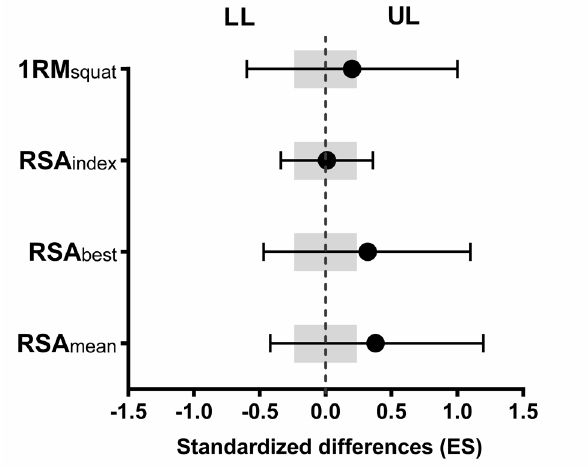
Figure 2. Differences in maximum strength in parallel back squat (1RM (RSA ) and mean sprint time (RSAmean) between groups linear (LL) and undulating load (UL). Was used Cohen effect-size principle best ± IC 90% compared absolute differences in raw values of the variables. The grey area represented trivial differences (see